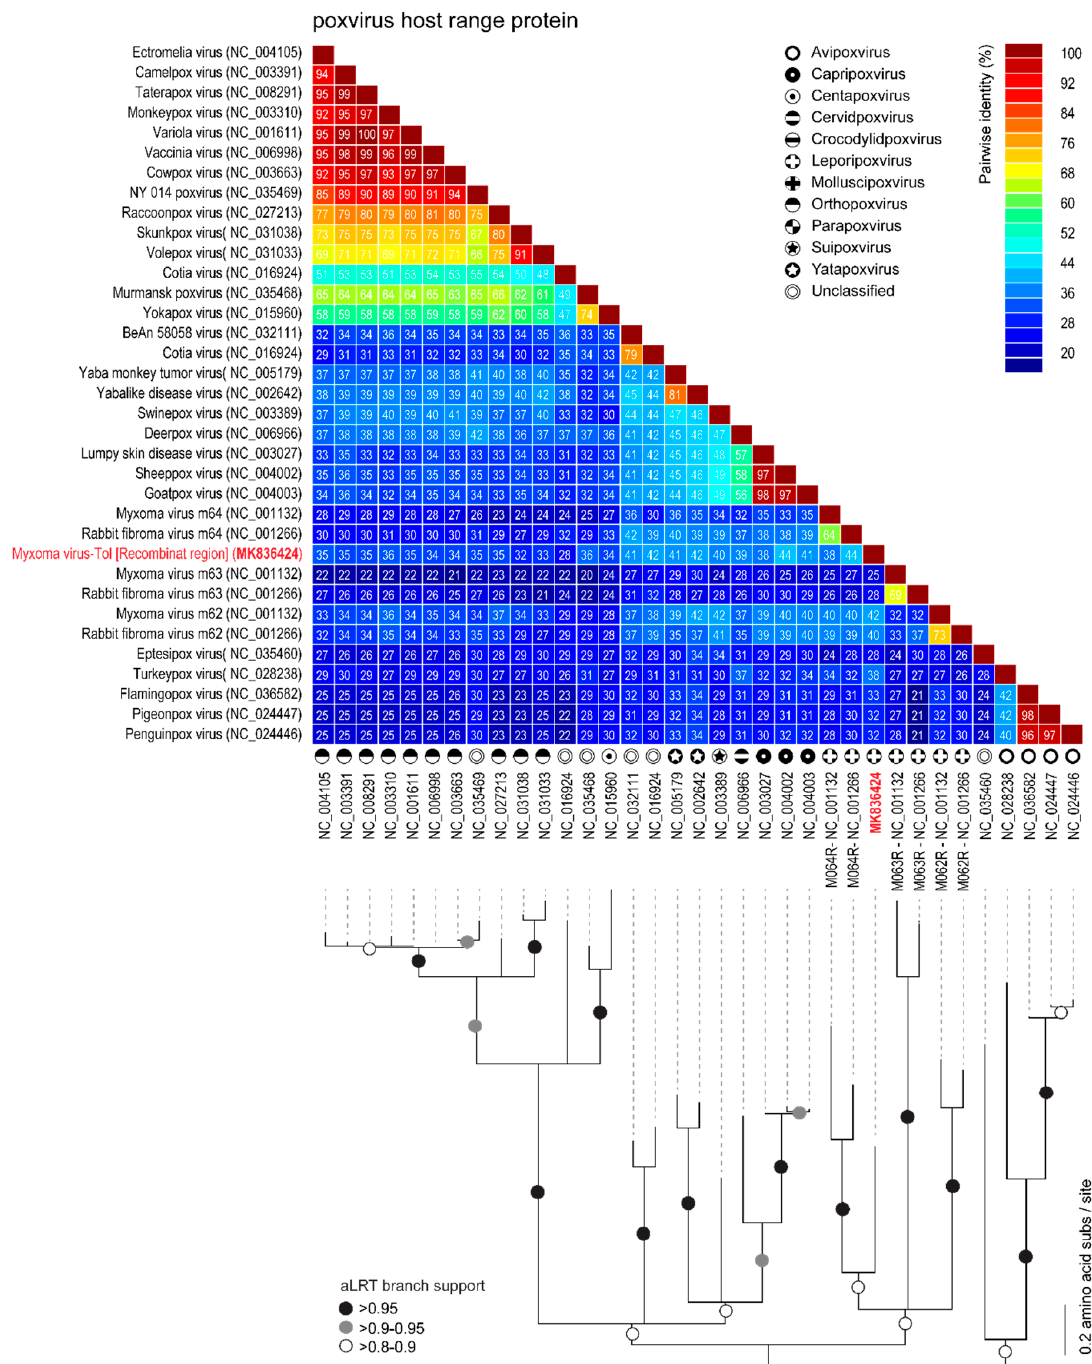
Figure 7. Pairwise amino acid identity matrix (upper image) and maximum-likelihood phylogenetic tree (JTT + G + F) showing the relationships of the rPox-host range protein (highlighted in red) found in the recombinant region of MYXV-Tol and its homologous proteins found in representative sequences (NCBI RefSeq) of poxvirus. Branches with aLRT support 0.95 are indicated by black circles whereas branches exhibiting 0.9–0.95 and 0.8–0.9 are indicated by grey and white circles, respectively.